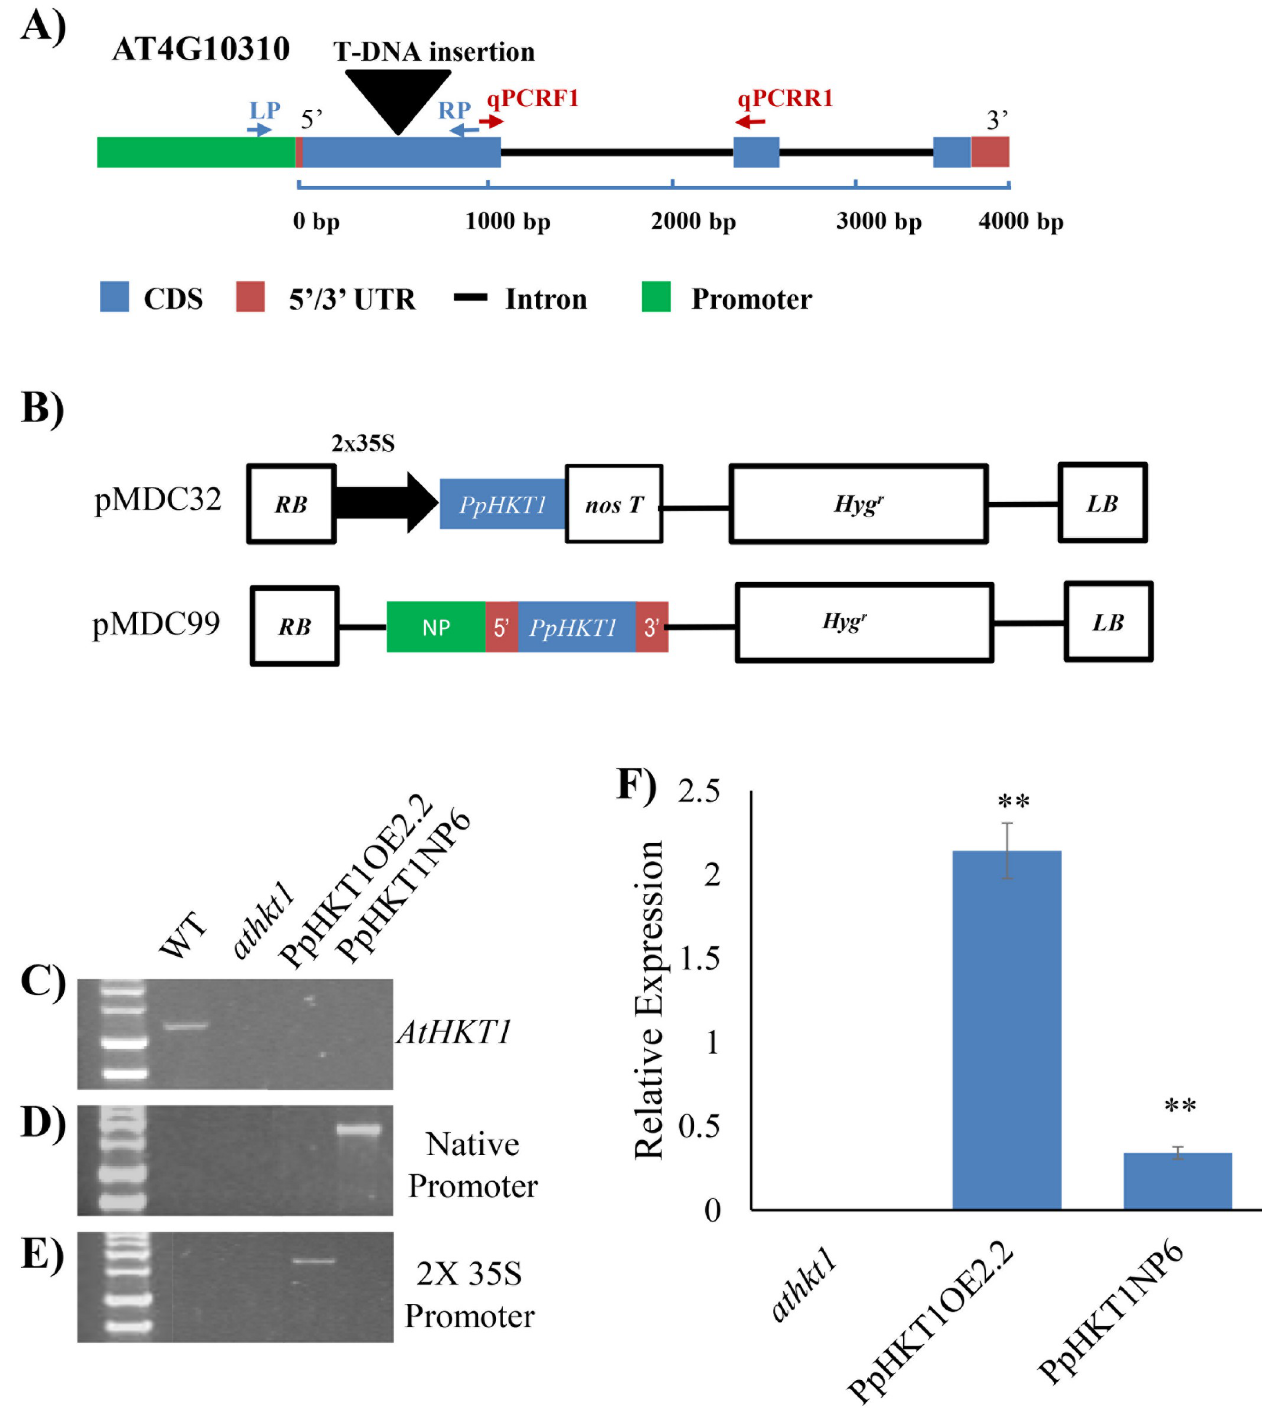
Fig 1. Screening of transgenic lines. A) Gene structure of athkt1 with T-DNA insertion and location of primers for genotyping and qRT-PCR. B ) Gene structure of overexpression construct in gateway vector pMDC32 and expression under native promoter in promoter-less gateway vector pMDC99. C) Screening of WT, athkt1 mutant and the transgenic lines by amplification with GABI_795G10_LP/GABI_795G10_RP set of primers specific to the AtHKT1 gene. WT had amplification of 1.2 Kb band and no amplification was seen in the athkt1 mutant or the transgenic lines. D) Screening of Arabidopsis lines expressing PpHKT1 under native promoter. The gDNA was amplified with PpHKT1_Start_F and PpHKT1_3’UTR_R set of primers. Only transgenic line harboring pMDC99 carrying native promoter construct amplified the 1.8 Kb amplicon. E) Screening of overexpressor line by amplification with 35SProm_F and PpHKT1_Stop_R set of primers. Only Arabidopsis line harboring pMDC32 carrying CDS construct amplified 1.7 Kb amplicon. F) Relative expression of